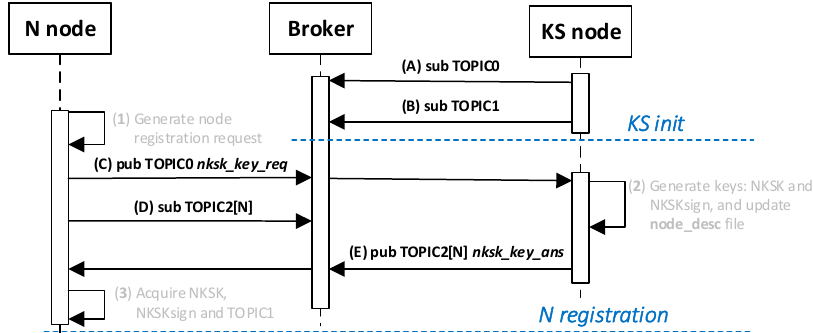
Figure 17. The sequence diagram of the data exchange in the Message Queuing Telemetry Transport (MQTT) service for the registration procedure.